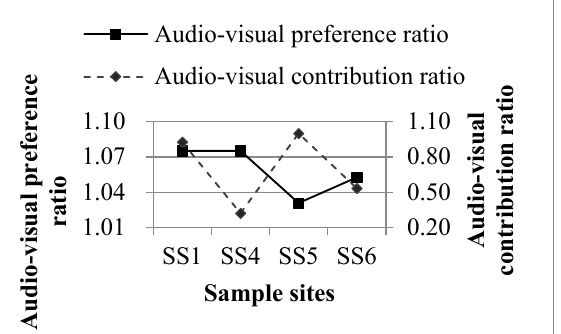
Figure 6. Ratio of audio/visual contribution to OLP and ratio of audio/visual preference.